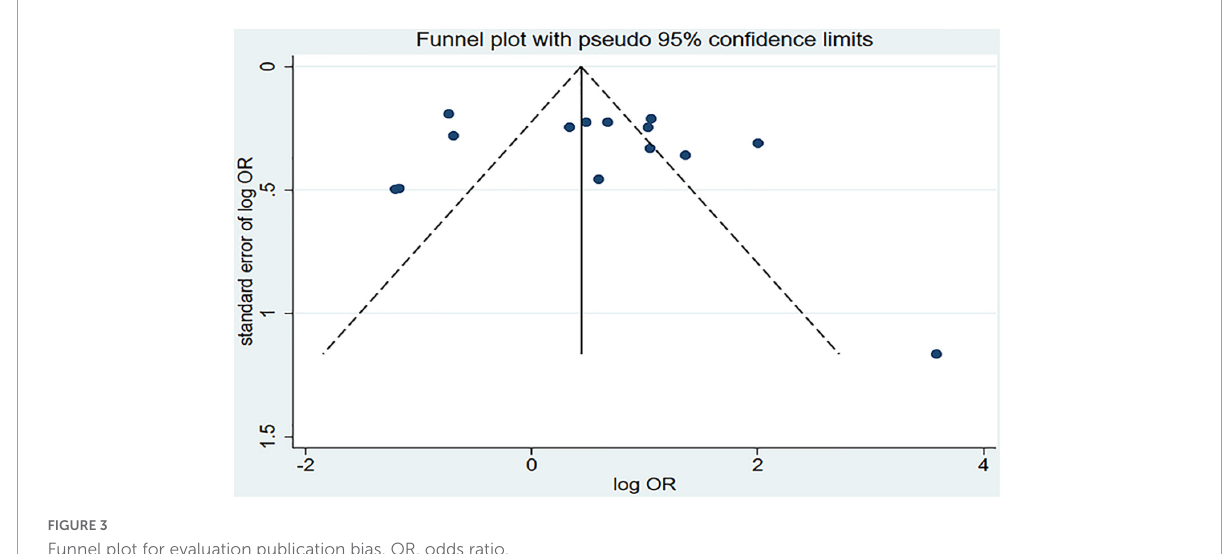
FIGURE3 Funnel plot for evaluation publication bias. OR, odds ratio.